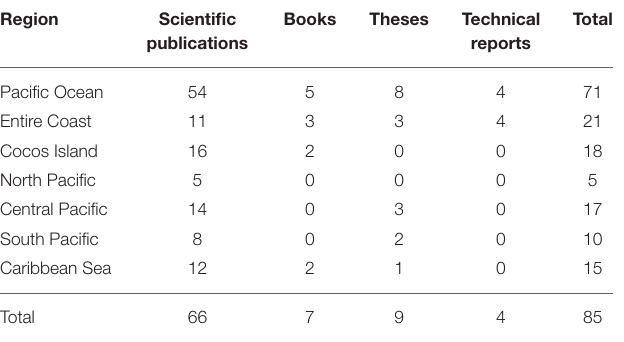
FIGURE 1 | Map of Costa Rica. Main fishing landing ports in the Pacific coast include: PC, Playas del Coco; PU, Puntarenas; QU, Quepos; GO,